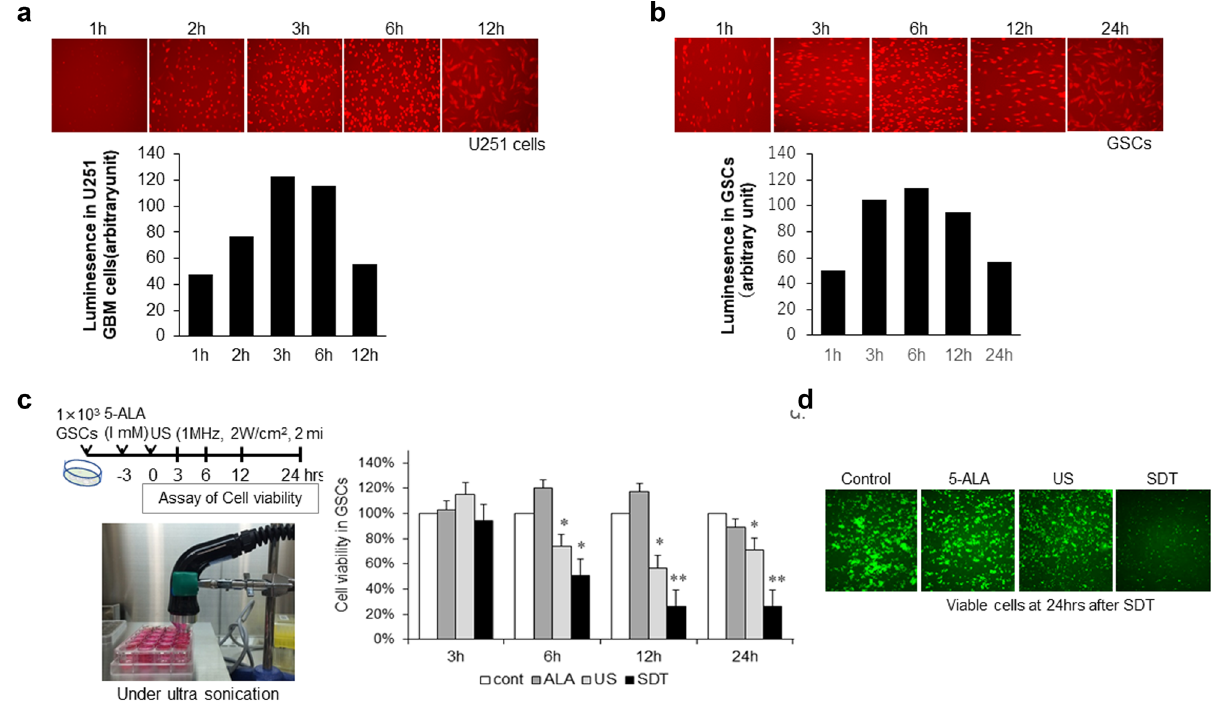
Figure 1. Cell viability by sonodynamic therapy (SDT) in mouse glioma stem cells (GSCs). ( a ) Changes of luminescence images and intensity in human glioblastoma U251 cells for 12 h after treatment with 1 μM 5-aminolevulinic acid (5-ALA) as a sonosensitizer. ( b ) Changes of luminescence images and intensity in mouse GSCs for 24 h after treatment with 5-ALA. ( c ) Protocol and photos under ultrasonication (US) and